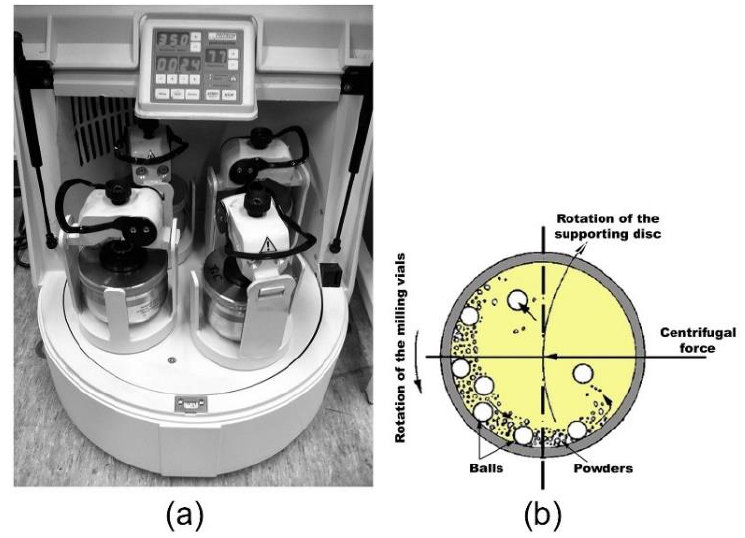
Figure 5. ( a ) Photograph of the Fritsch Planetary-type high energy ball mill (Pulverisette P5). The movement of the balls during the milling process is schematically depicted in ( b ). The equipment is housed in three locations: NAP, EBRC, and KISR.